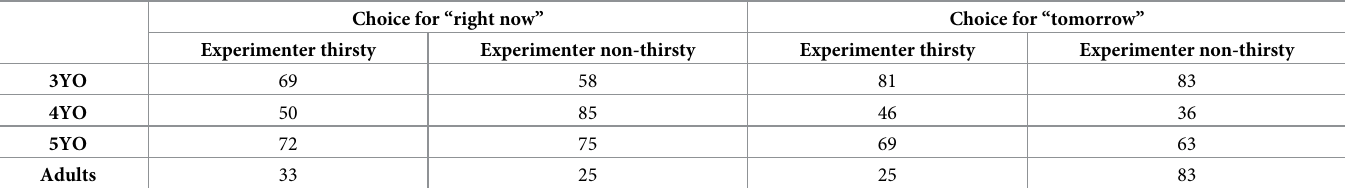
Table 3. Percentage of participants choosing crisps for themselves as a function of age and